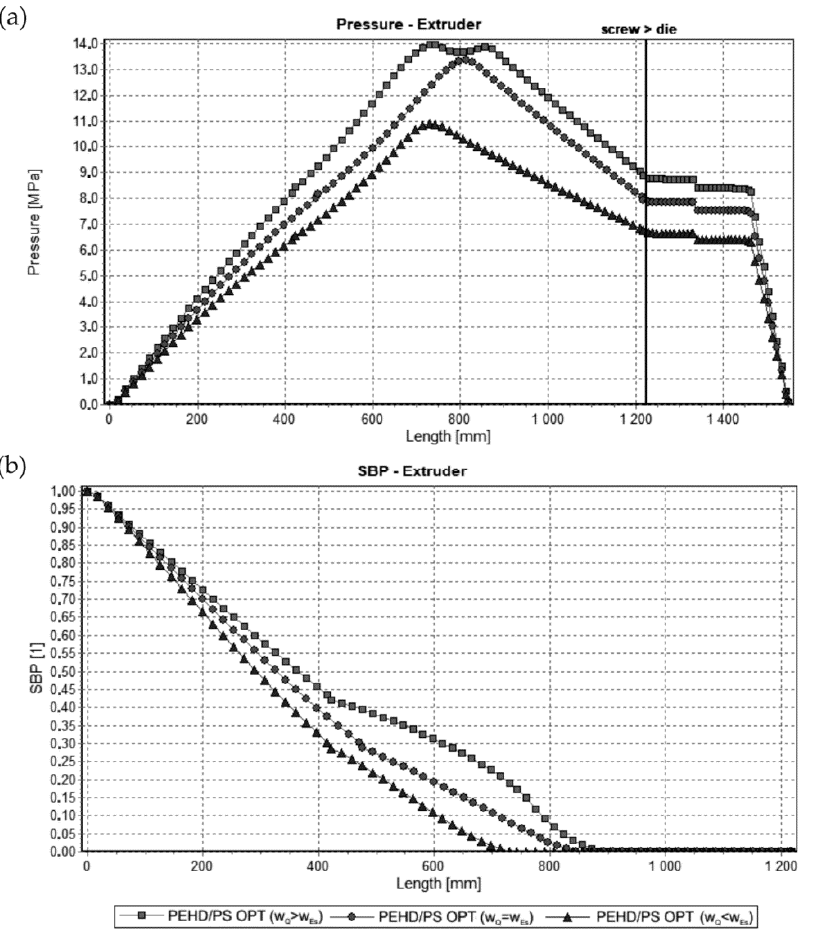
Figure 8. Simulations for flood fed extrusion at optimal process parameters for various weights of optimization criteria w Q and w Es (adapted from [68]): ( a ) pressure profiles, ( b ) melting profiles (SBP, i.e., solid bed profile).